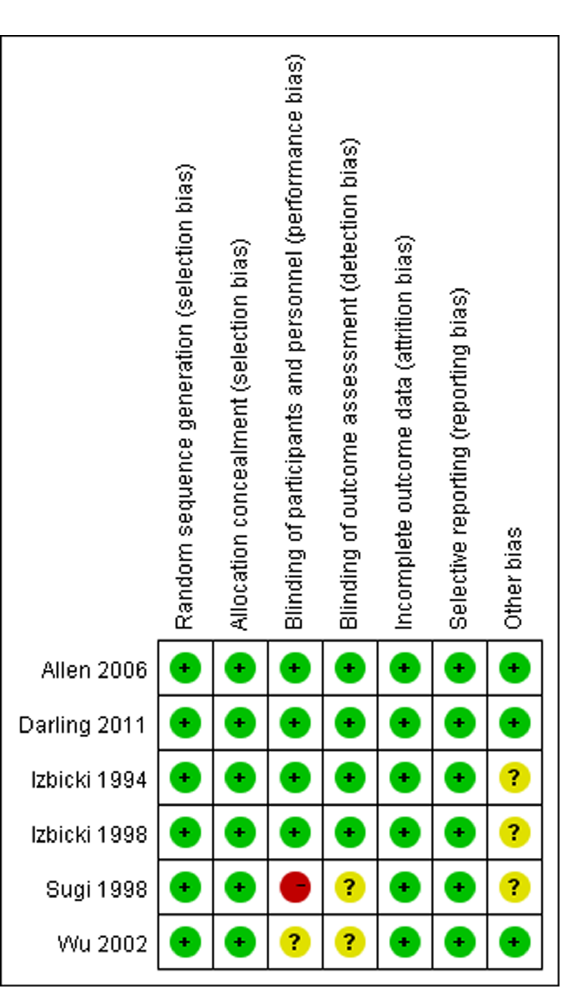
Figure 2. Risk of bias summary: review authors’ judgements about each methodological quality item for each included study. ‘‘ + ’’, ‘‘ 2 ’’ or ‘‘?’’ reflected low risk of bias, high risk of bias and uncertain of bias respectively.